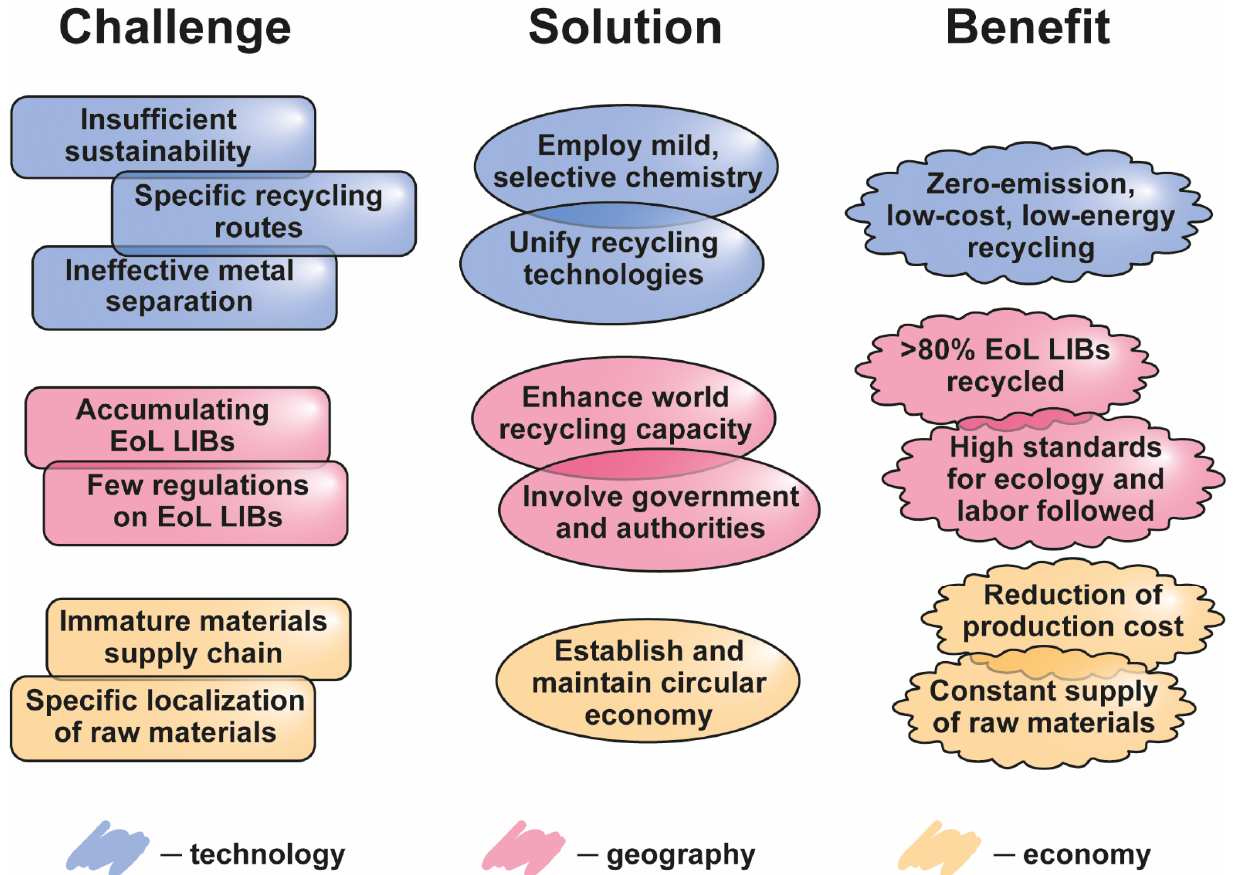
Figure 7. Perspective roadmap of EoL LIB recycling development illustrating the existing challenges, proposing solutions, and benefits that can be gained as a result of solutions implementation.